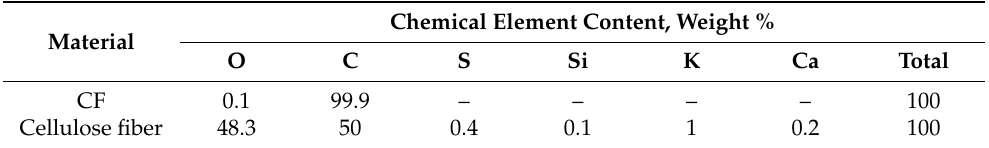
Table 1. Chemical composition of CF and cellulose fiber.